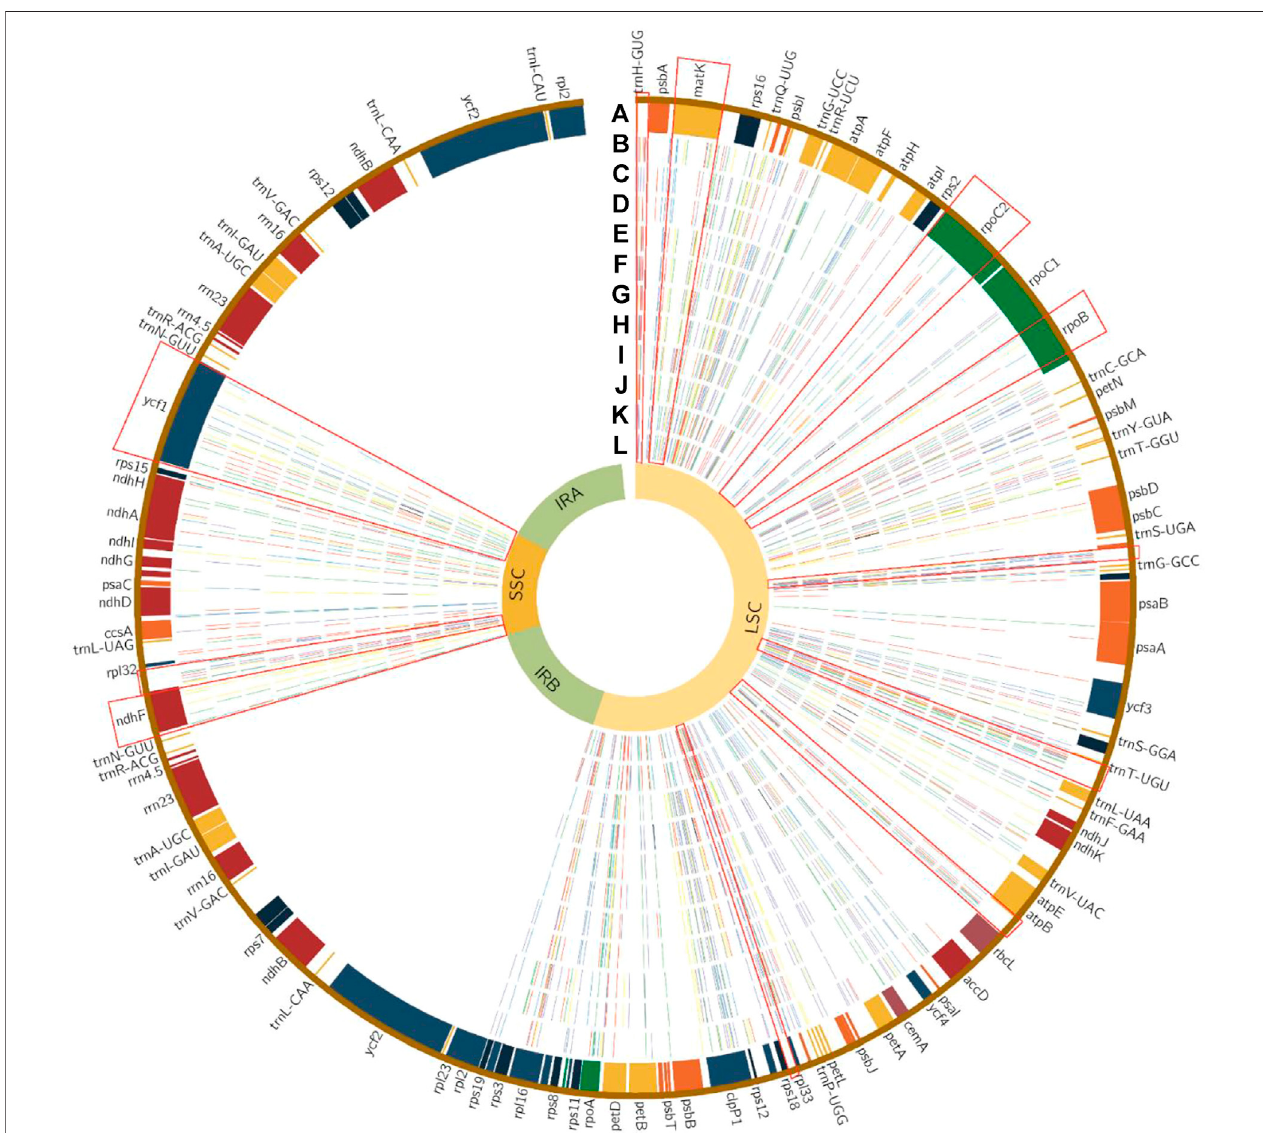
FIGURE4| Singlenucleotide polymorphicsitesin12chloroplastgenomesof Tilia. TrackArepresentstheencodinggenes.TracksB – Lrepresentvariant sitesin T. tomentosa , T. americana , T. miqueliana , T. cordata , T. mandshurica , T. paucicostata , T. taishanensis , T. oliveri , T. insularis , T. amurensis and T. mongolica compared with T. endorchrysea. The red, blue, yellow and green lines on each track indicate the kinds of variant, A, T, C and G nucleotides, respectively.Purple lines indicate InDel regions. The red rectangles represent the locations of the 11 selected hypervariable regions.